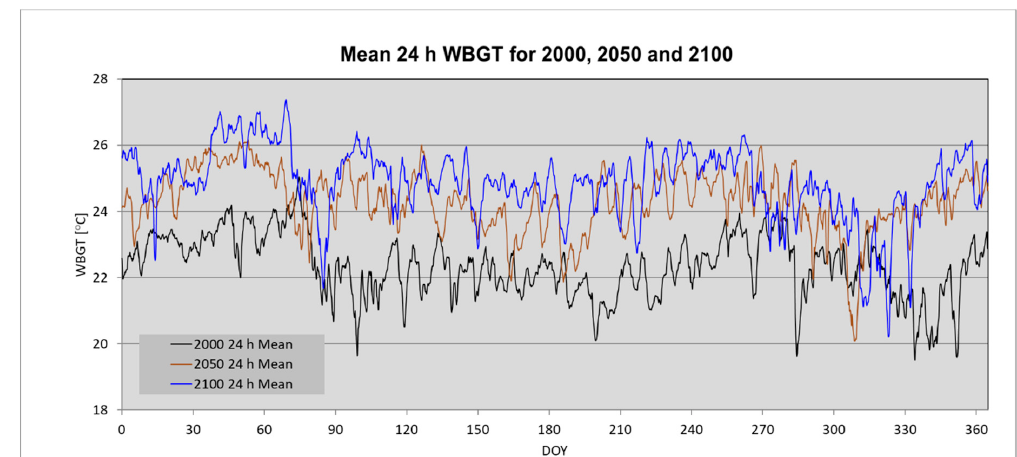
Figure B1. Mean 24 h WBGT (°C) variability for one grid-cell in the year 2000, 2050 and 2100. WBGT calculated using near-surface relative humidity (RH, %), surface down welling shortwave radiation (Rs, W m − 2 ) and surface air temperature (Ta, °C) at 2 m were derived from historical (year 2000) and RCP4.5 simulations (years 2050 and 2100) with the Second-Generation Canadian Center for Climate Modelling and Analysis Earth System Model (CanESM2) [56].